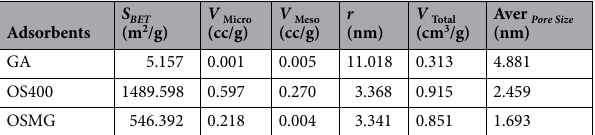
Table 2. Pore structure parameters of garnet GA, Olive stones carbons OS400 and